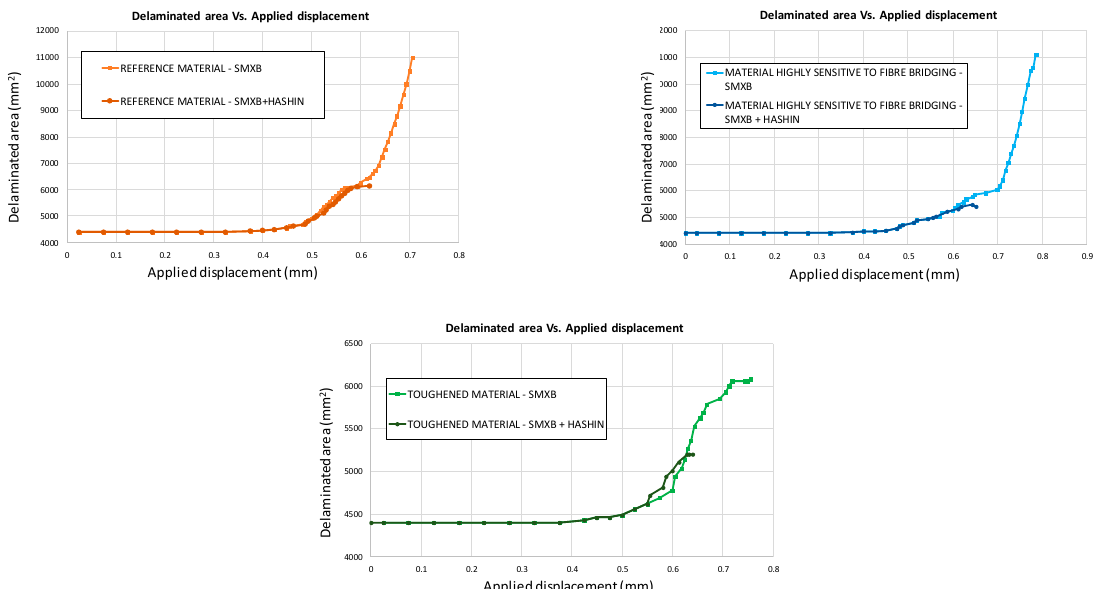
Figure 11. Delaminated area vs. Applied displacement comparison.